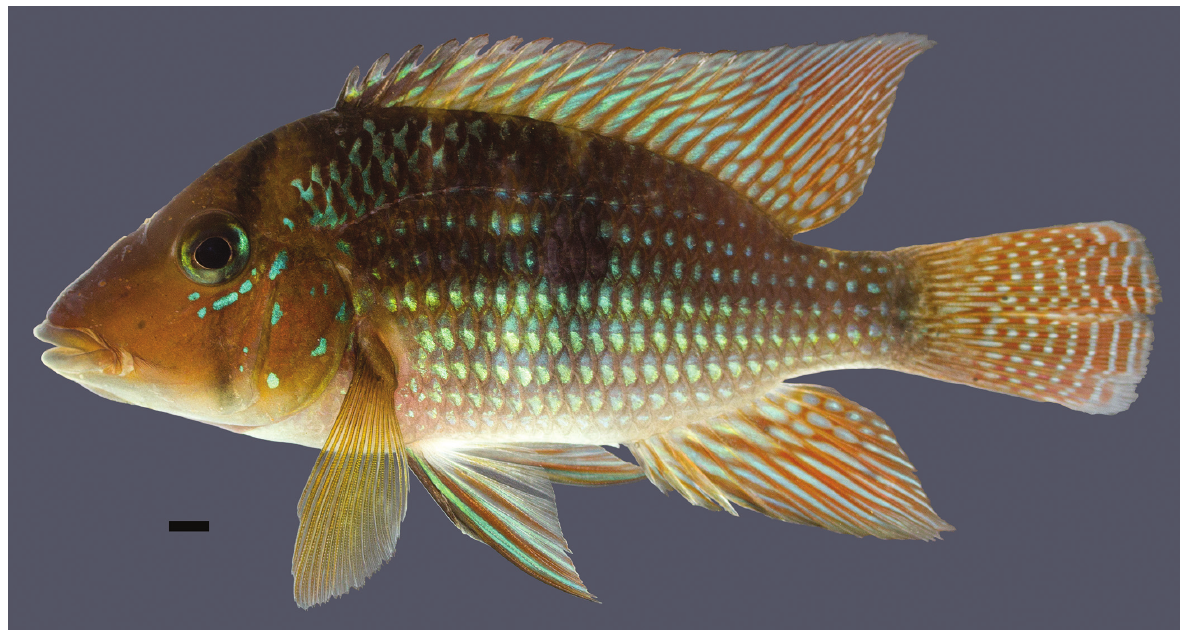
Figure 6. Geophagus santosi , UFRJ 11765, holotype, 110.6 mm SL; Brazil: Bahia: Mariana River. Scale bar 10 mm. Photograph by J.L.O.